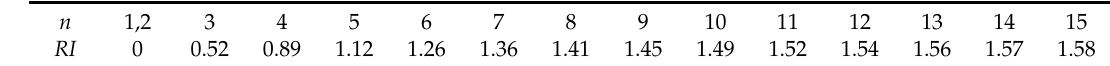
Table 3. RI values for different matrix